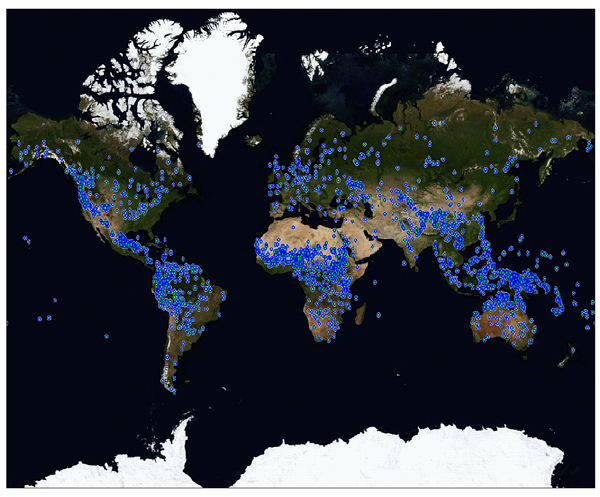
Figure 1. Geographic distribution of the 2,236 languages included in the present